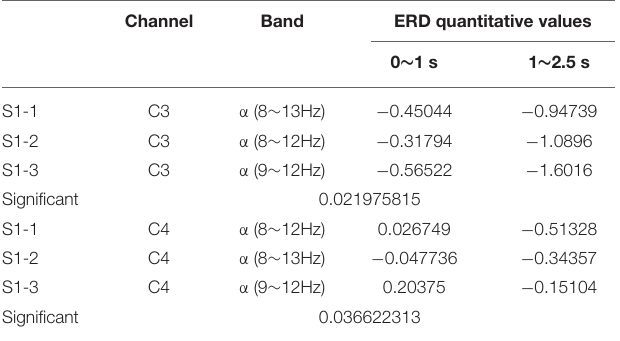
TABLE 2 | T -test of ERD phenomena for C3 and C4. TABLE 3 | The fatigue-sensitive channels of the young and elderly subjects on the parietal